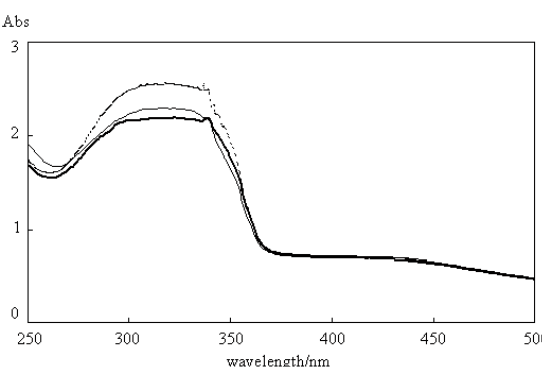
magnetization field 12